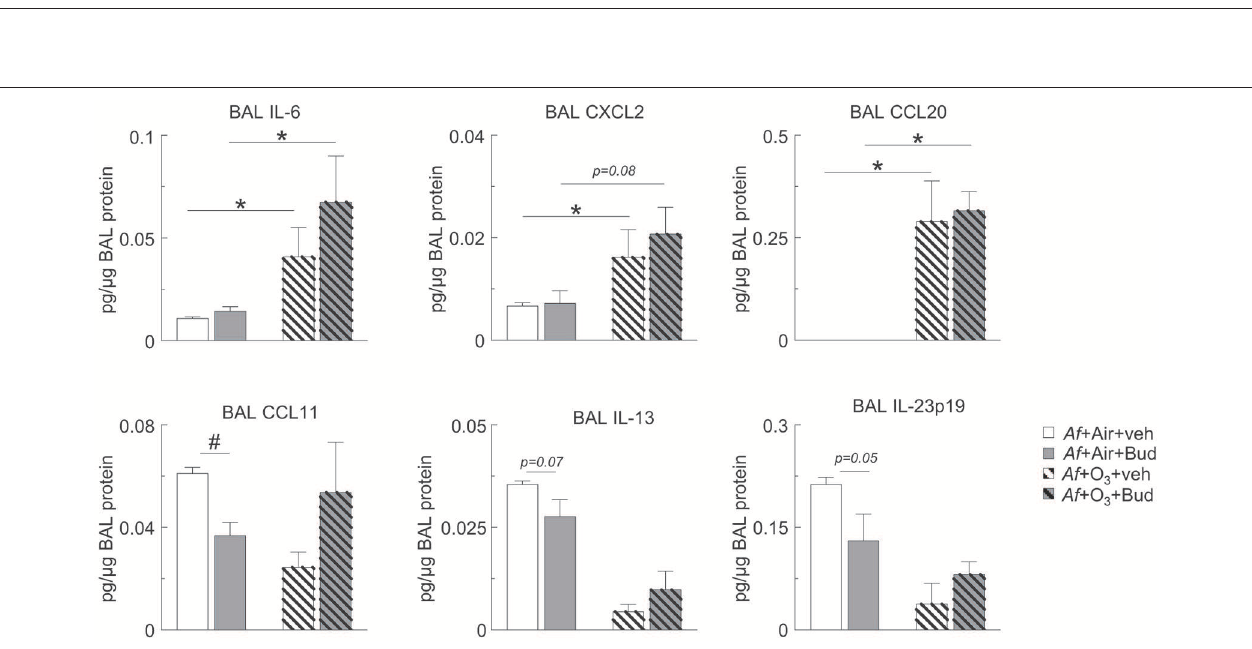
Frontiers in Immunology |